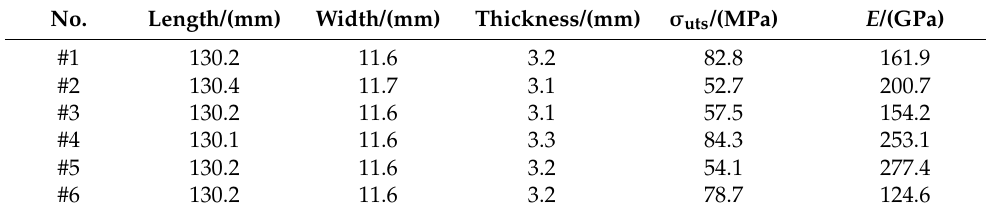
Table 1. Tensile mechanical properties of the 12k T-700 TM MWK–N–C/SiC composite.